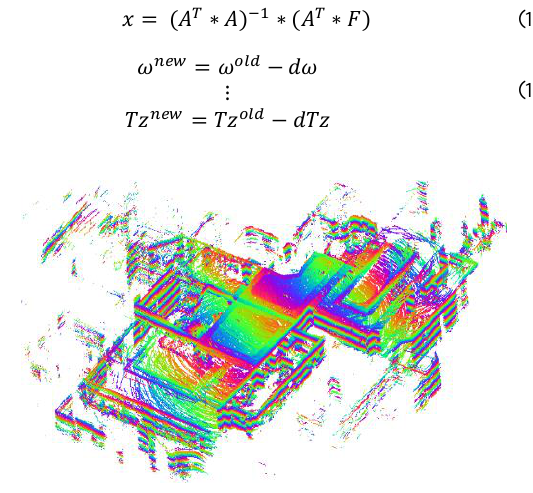
Figure 6. Output map based on proposed